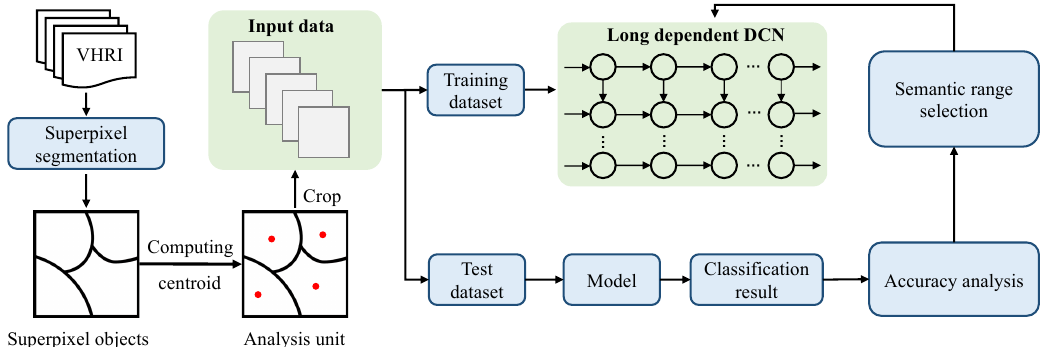
Figure 2. Methodology